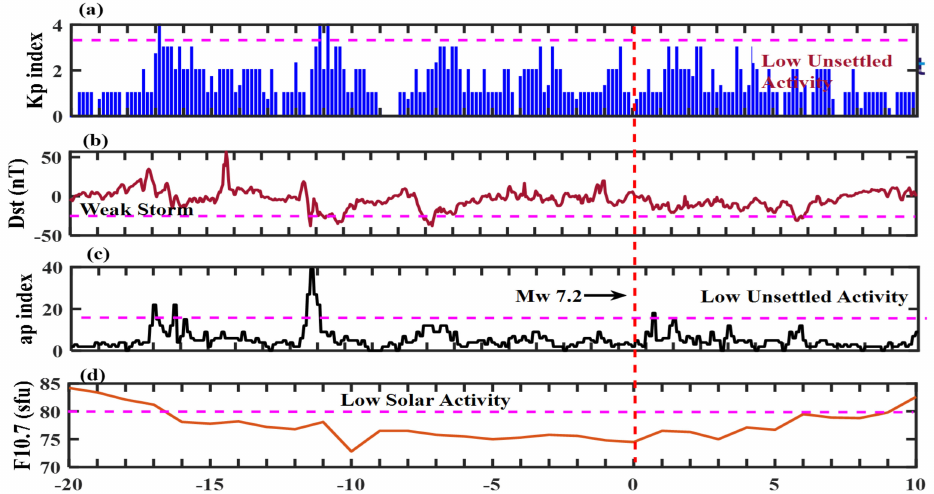
Figure 2. The solar and geomagnetic storm indices of ( a ) Kp, ( b ) Dst, ( c ) ap and ( d ) F are 10.7. The red color dashed line is for EQ day across all panels.